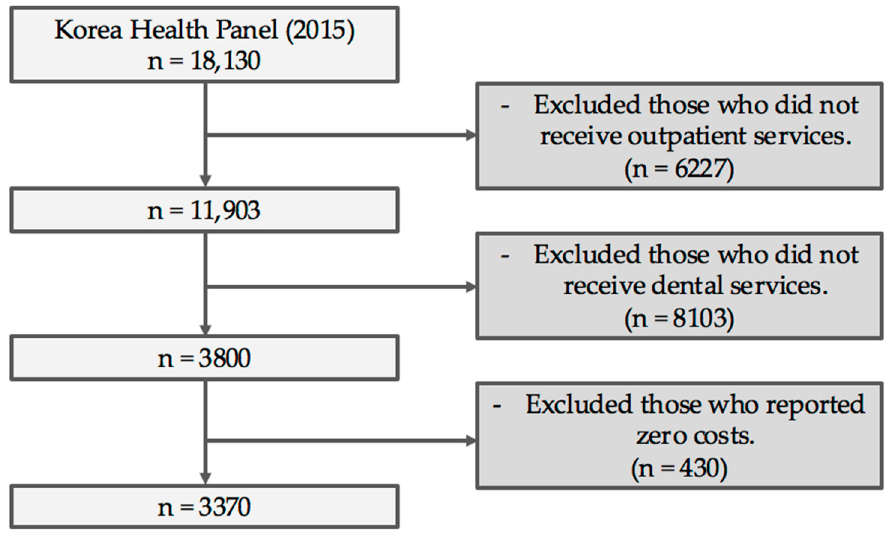
Figure 1. Flow of sample selection in this study .